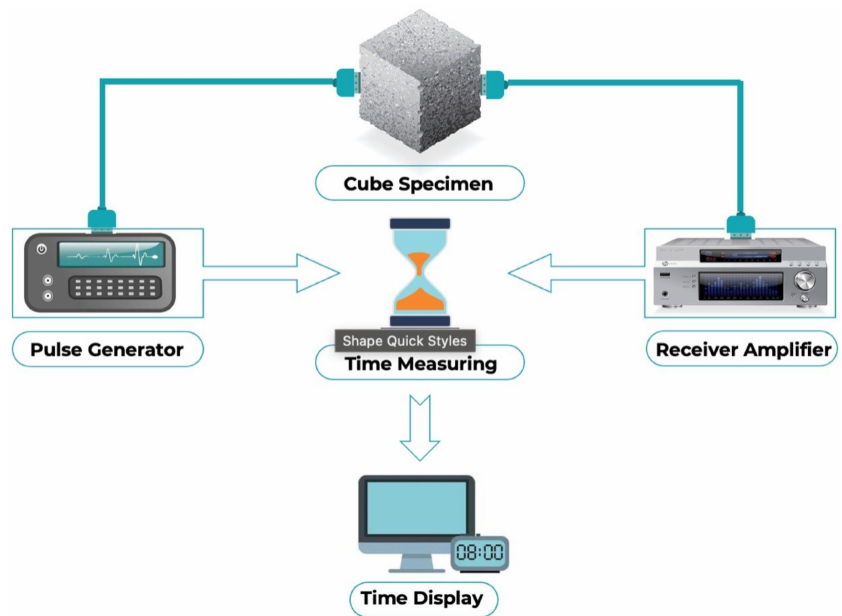
Figure 3. UPV testing procedure.